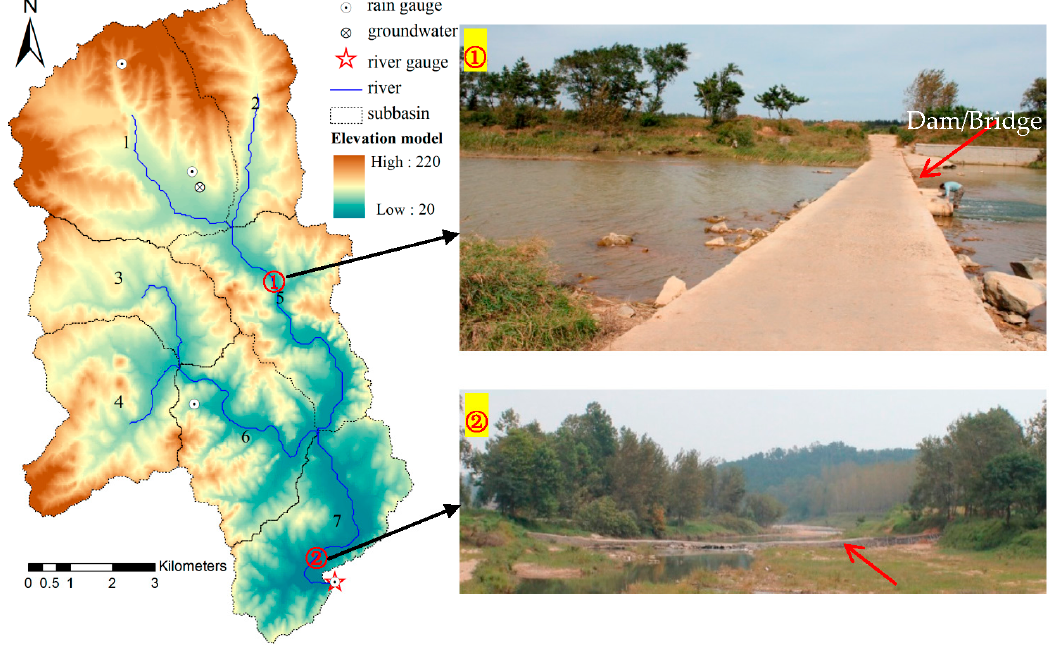
Figure 11. Two physical photographs of small dams across the main channel in the Baocun watershed.